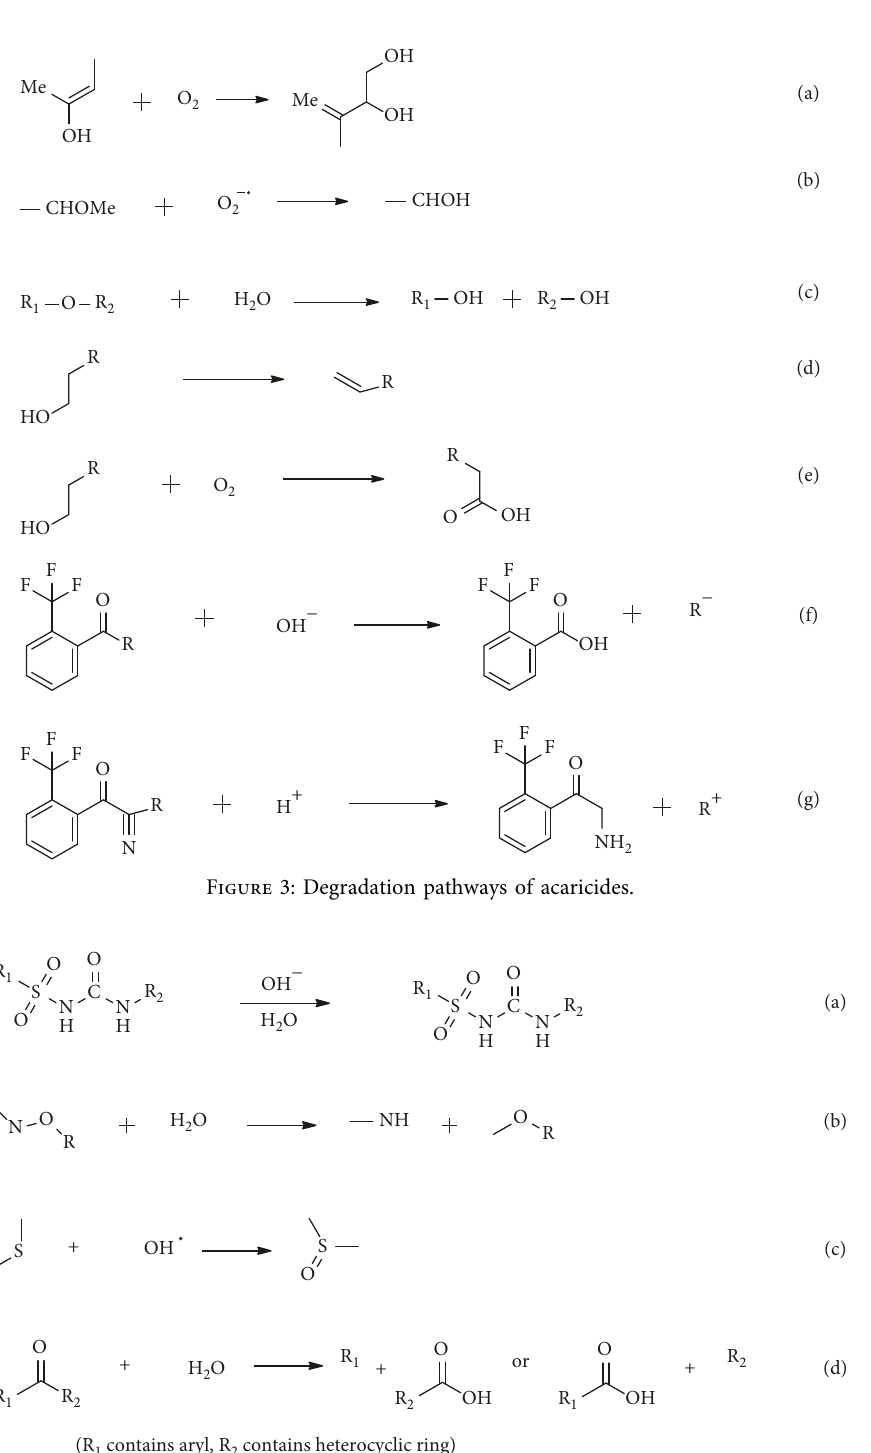
Figure 4: Main photolysis mechanism of herbicides.